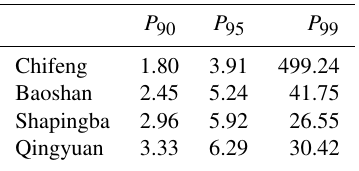
Table 5. Percentiles of the relative error between Aeolus detection and L-band RS data for four regions. P 90 represents the boundary value of the range where 90% of the relative error falls. The mean of P 95 and P 99 are similar to P 90